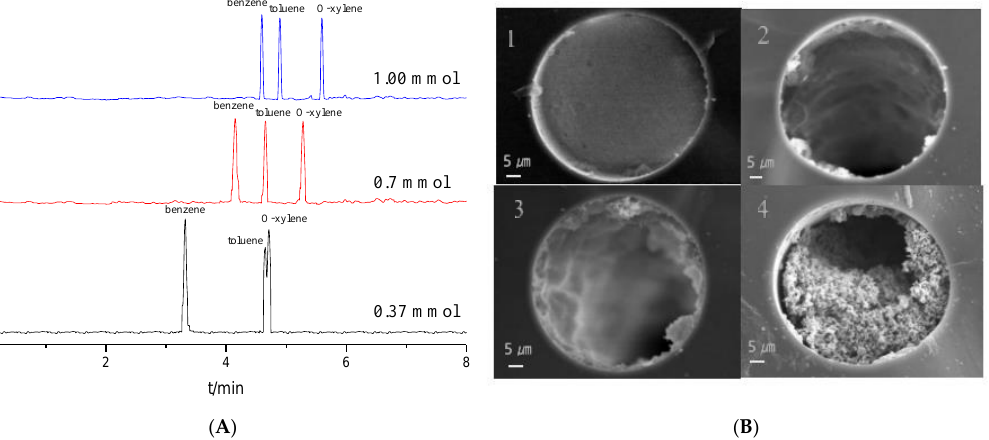
Figure 2. Separation chromatograms for benzene, toluene and o-xylene with different Tp dosage when coating times were three ( A ); SEM images for the cross section of the TpBD COF immobilized capillary (×1.0 k) with different coating times when the Tp dosages was 0.70 mmol ( B ). Experimental conditions: 20 mM phosphate buffered solution (pH 8.0); operating voltage, 15 kV. Coating times is another crucial factor in separation performance. The OT columns coated from one to four times were prepared (Figure 2B). The distribution in the stationary phase in the column is not uniform and very thin when the column was coated once with low column efficiency. When a process with two coatings was performed, both the thick- ness of the stationary phase and column efficiency slightly increased but uniformity re- mained poor. The stationary phase in the OT column bonded well and distributed uni- formly after three coatings, and the OT column showed the highest column efficiency of 26,776 plates/m. When coating times was four, the capillary column was almost blocked. So, a process with three coating times was chosen optimal. To verify if TpBD COF was bonded to the inner wall of the capillary, TpBD COF immobilized capillary, as prepared, was characterized by FTIR, XRD, TG, SEM, TEM, EDS and nitrogen adsorption–desorption (Figures 3 and 4). Figure 3. SEM images for the cross section of the TpBD COF immobilized capillary. ( A ) The bare column (×1.0 k), ( B – E ) TpBD COF immobilized capillary (×1.0 k, ×10.0 k and ×20.0 k) and ( E – H ) EDS